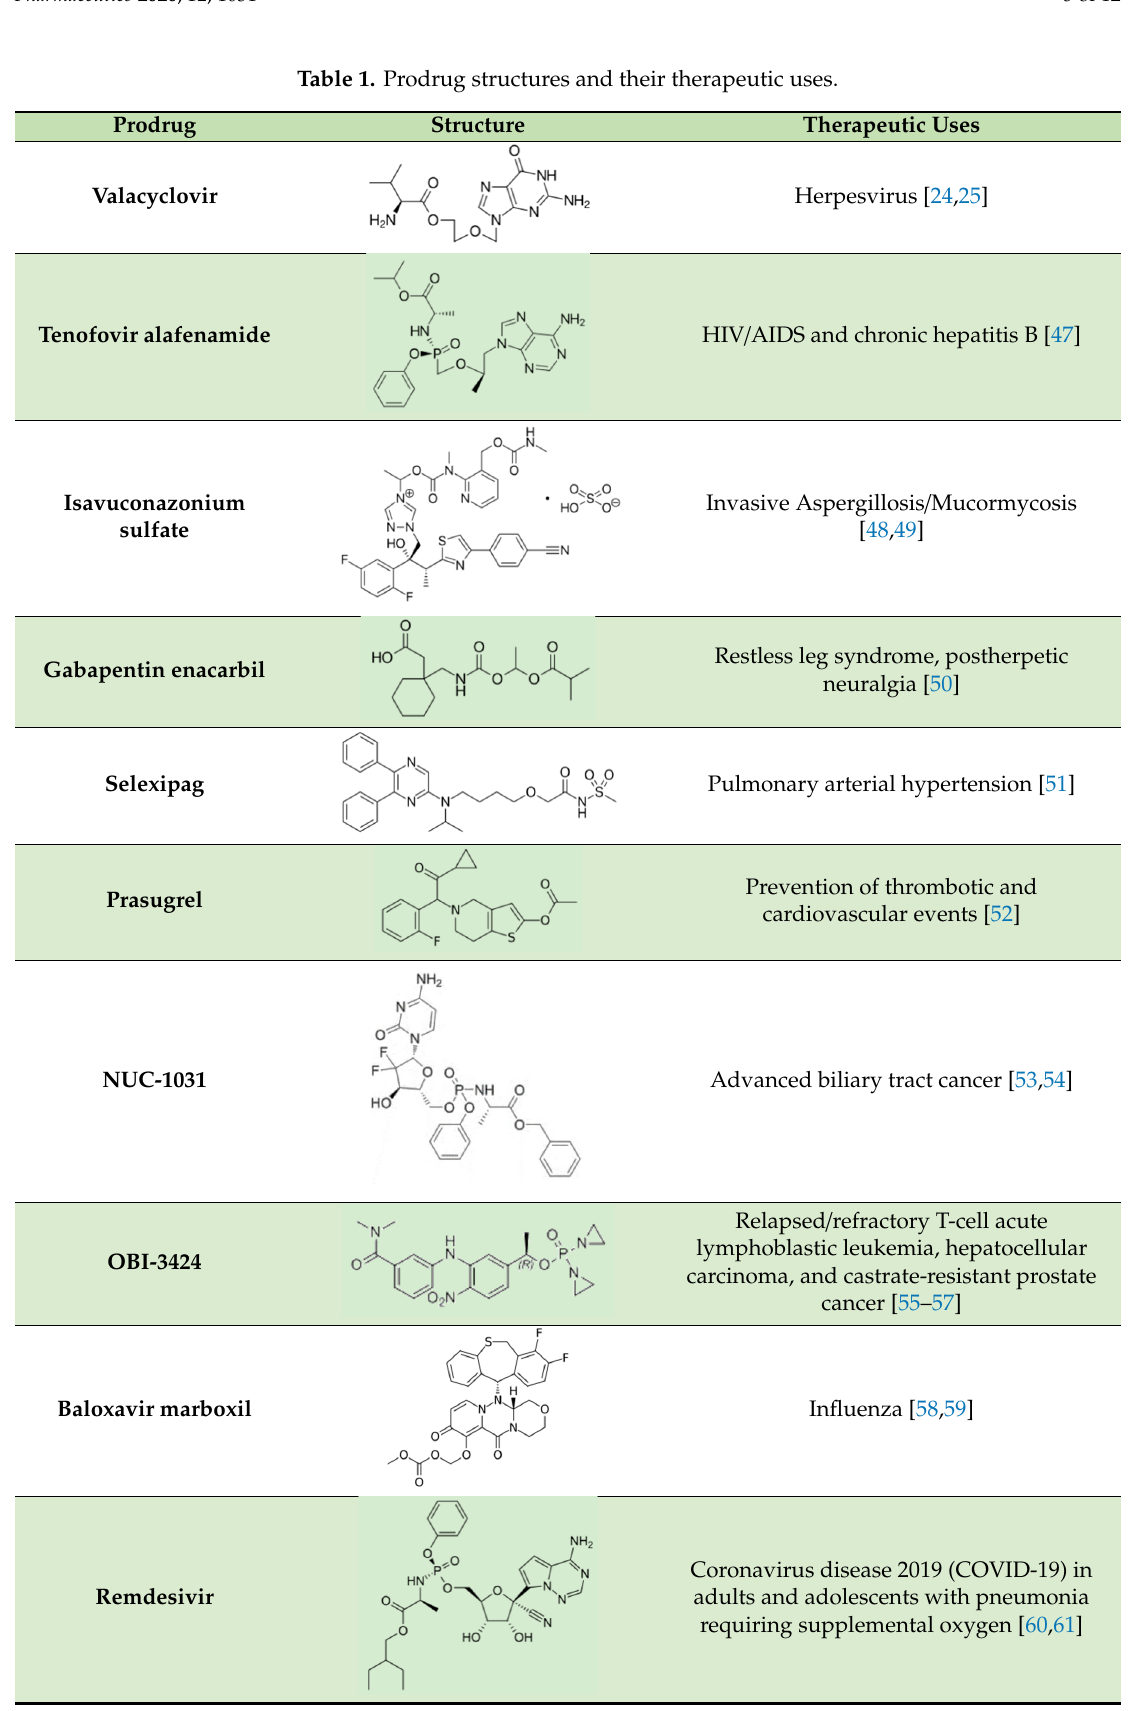
Table 1. Prodrug structures and their therapeutic uses.